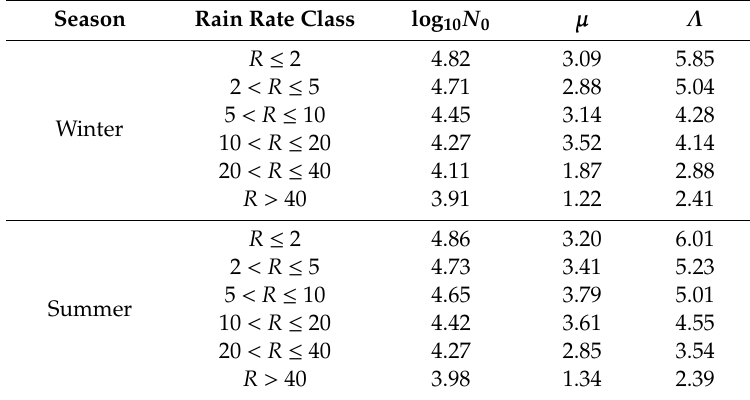
Table 4. Mean values of gamma distribution parameters in terms of six rain rate classes. Season Rain Rate Class log 10 N 0